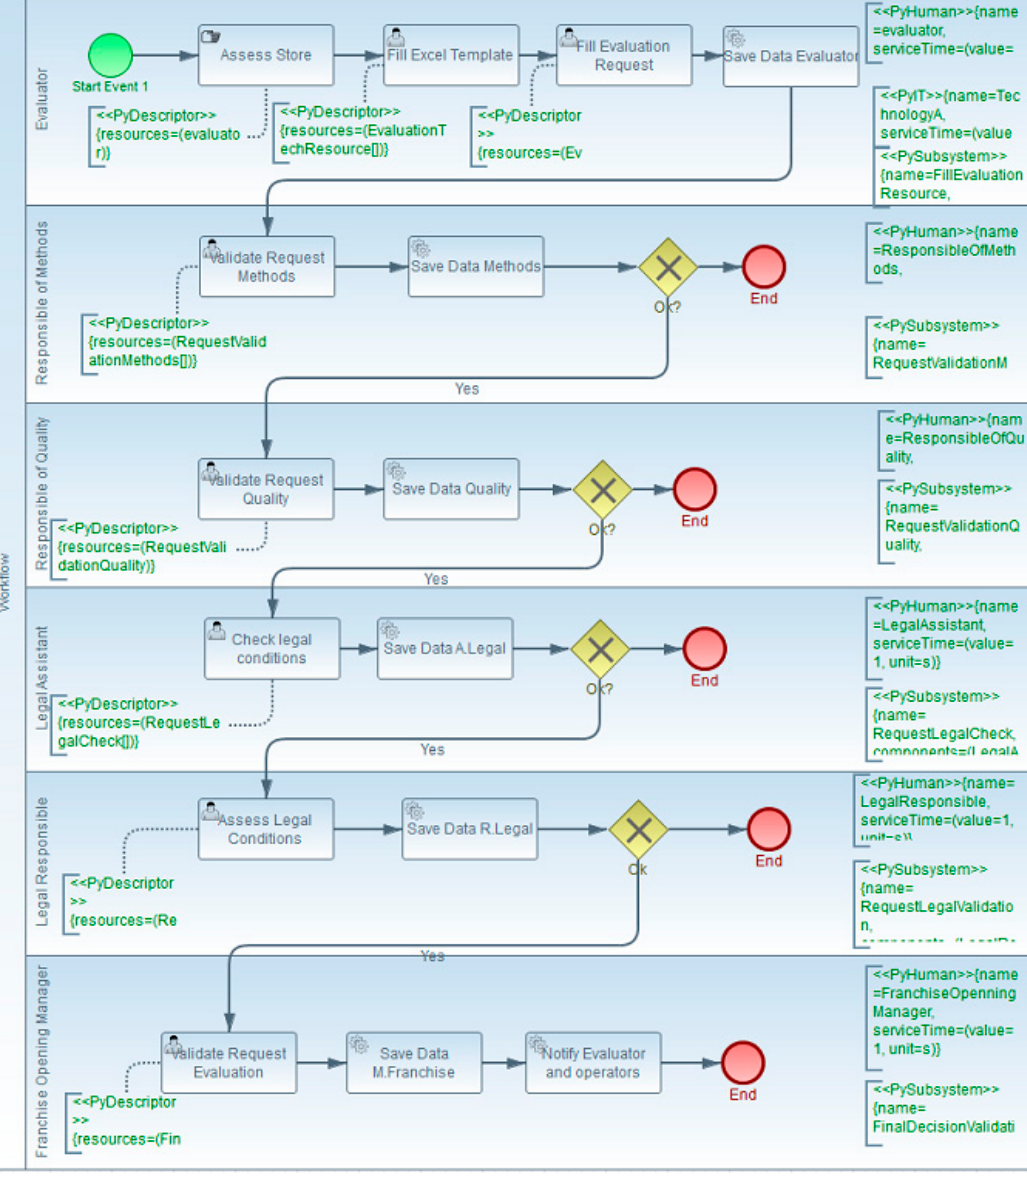
Figure 13. Operational process